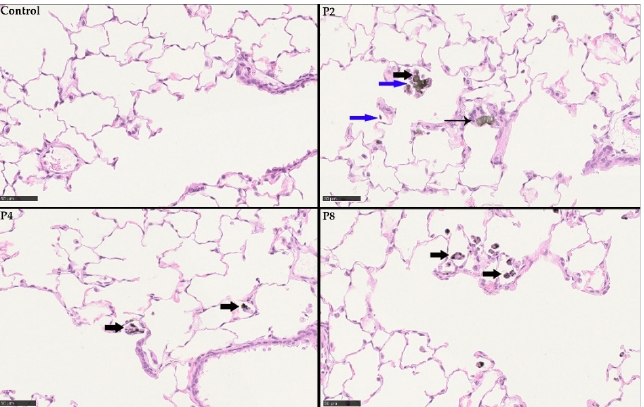
Figure 11. Histopathological findings at day 1 post-exposure following 28 days of inhalation. Control without any histopathological findings. P2 (SLG) high-dose group with particle-laden macrophages (bold black arrows), particle-laden giant cells (syncytia; black arrow) and infiltration of granulocytes (blue arrow). P4 (GNP) high-dose group with particle-laden macrophages (bold black arrows). P8 (CB) also with particle-laden macrophages (bold black arrows).